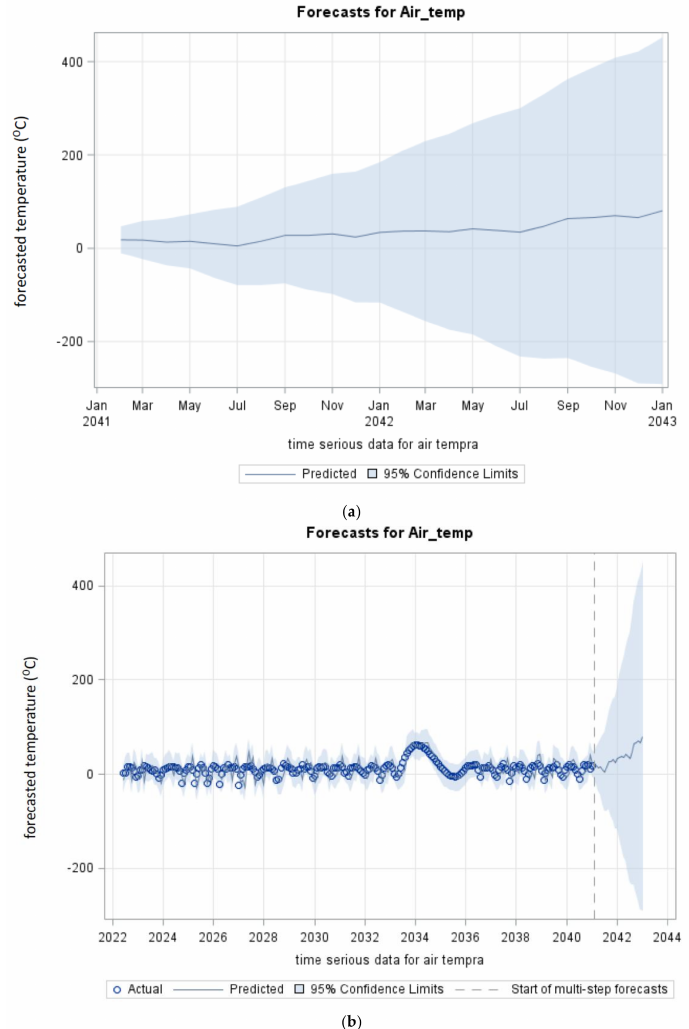
Figure 11. ARIMA analysis for the air temperature forecast over time from the Vaasa airport weather station. In the figure -200 = minus 200. ( a ) shows temperature forecast from 2041 to 2043. ( b ) shows forecast in air temperature from 2022 to